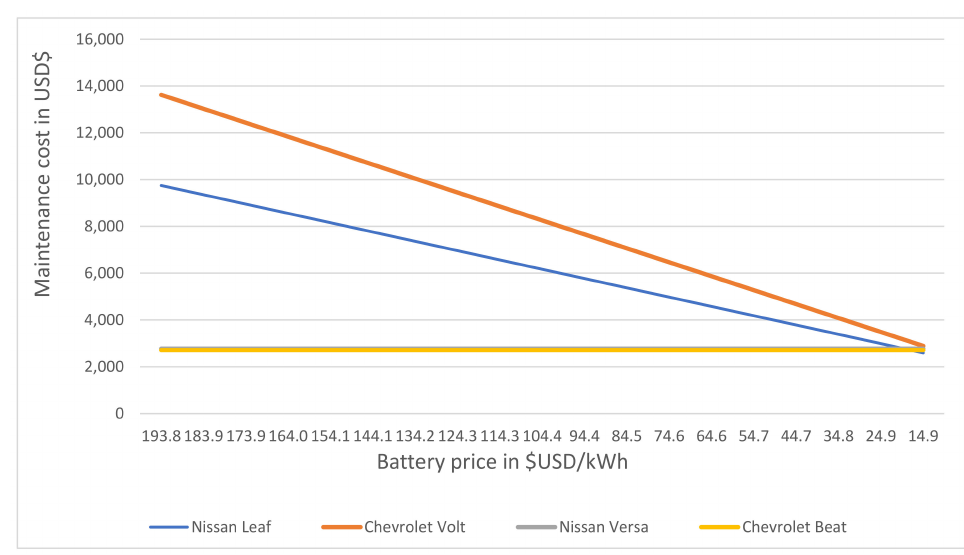
Figure 11. Effect of the battery price on the total maintenance cost.